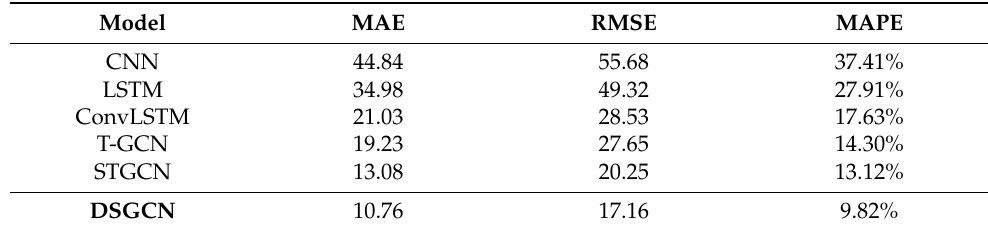
Table 3. Results of the evaluation of the DSGCN model and other baseline method models in the dataset at 45